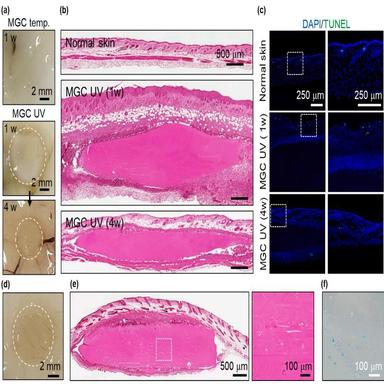
In vivo analysis of MGC-based thermogels. (a) Optical images of MGC hydrogels crosslinked by either body-temperature (MGC temp) only or UV exposure after injection (MGC-UV), sacrificed after 1 and 4 weeks of implantation (scale bar = 2 mm). (b) H&E staining of tissue implanted for 1 and 4 weeks with MGC hydrogels crosslinked by UV exposure after injection (scale bar = 500 μm). (c) TUNEL assay and high magnification images of subcutaneous tissue in each group (scale bar = 250 μm). (d) Optical images of chond